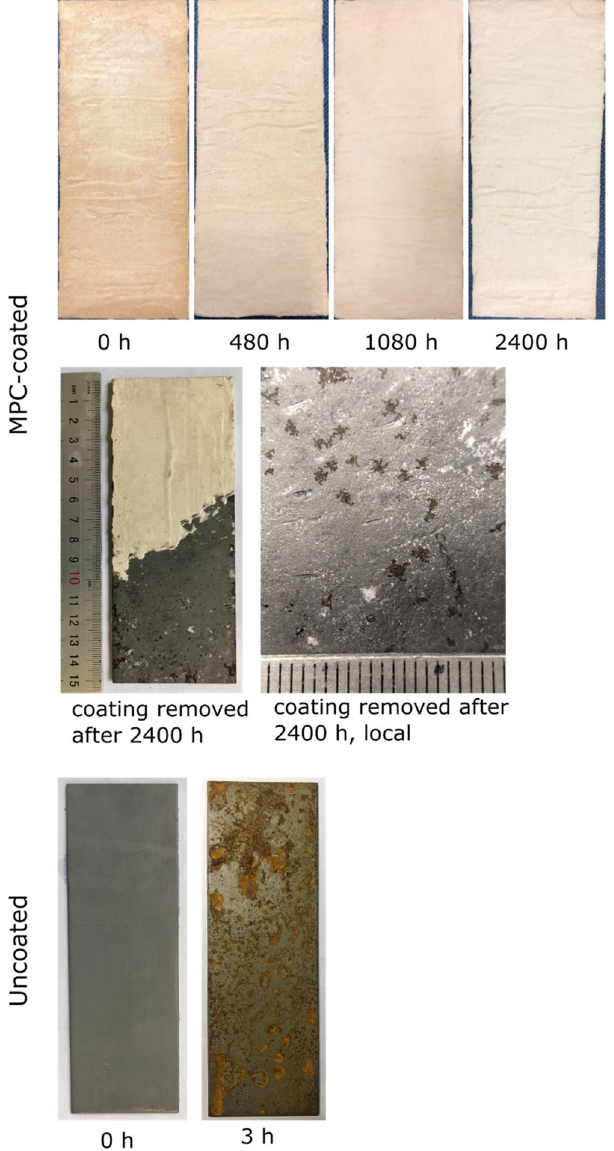
Figure 7. Photographs of a coated mild steel panel (150 × 70 mm) (upper panel) during salt spray for up to 2400 h, (middle panel) the panel chiseled to remove coating after 2400-h salt spray, and (lower panel) an uncoated panel before and after salt spray for 3